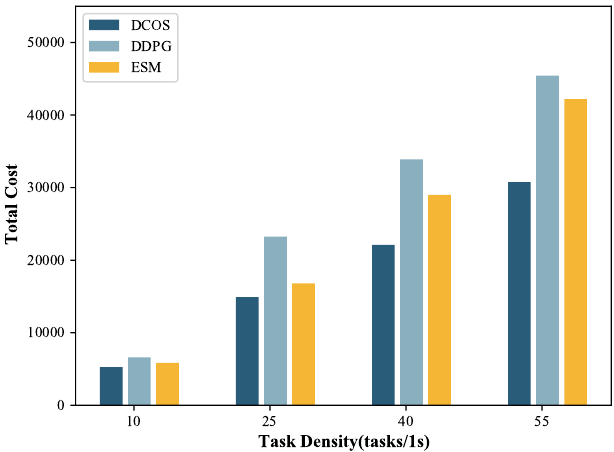
Figure 6. Total cost comparison for different task